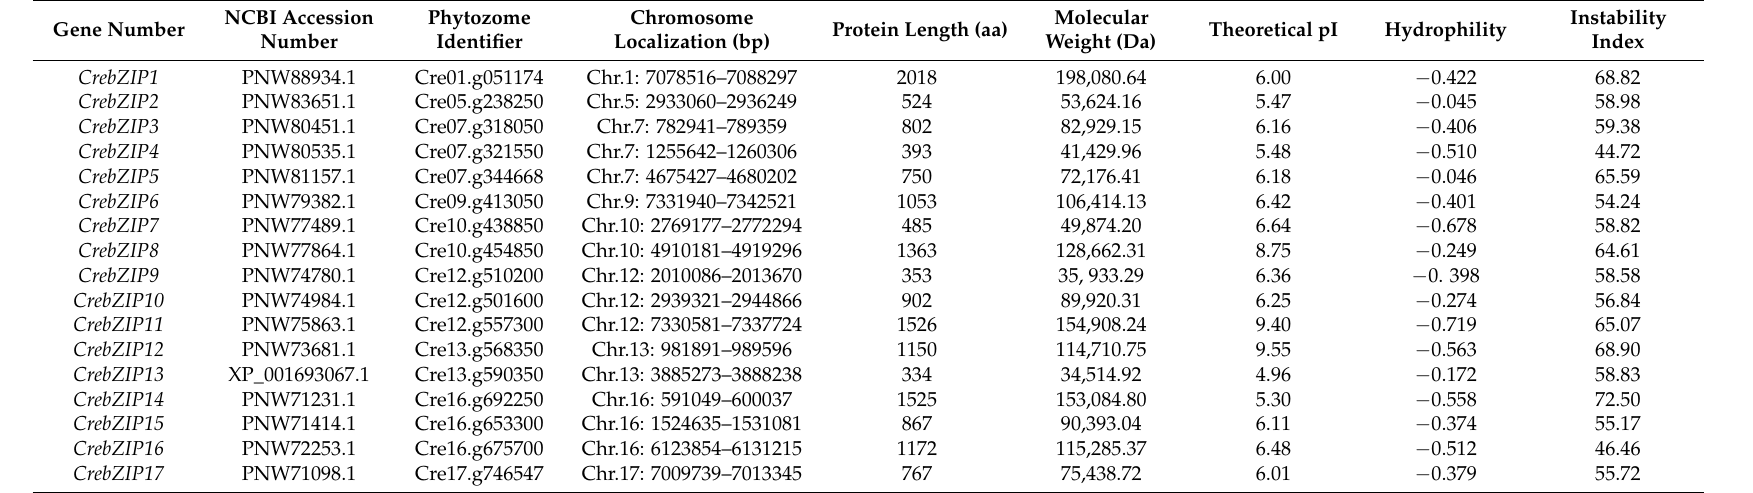
Table 1. Physicochemical properties of CrebZIP gene coding